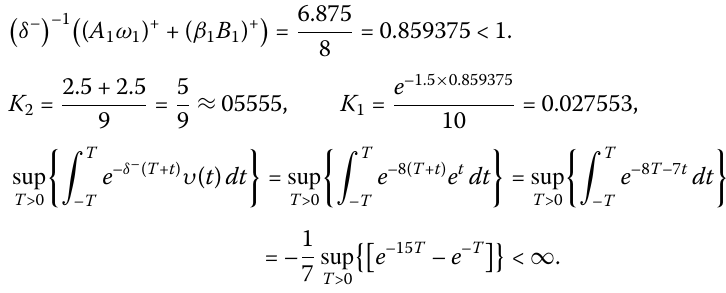
And for υ ( t ) = e t and δ – = 8, δ + = 10, A + τ = 1, we